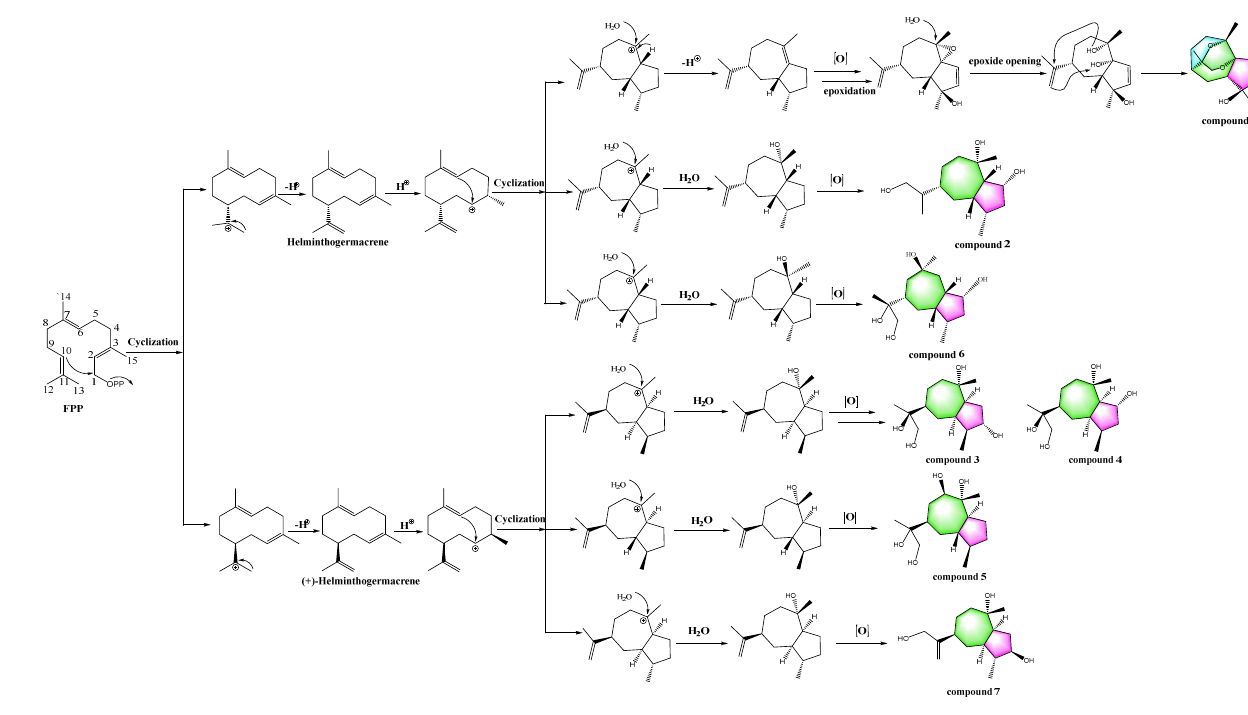
Figure 5. Plausible biosynthetic pathway of compounds 1 – 7 .